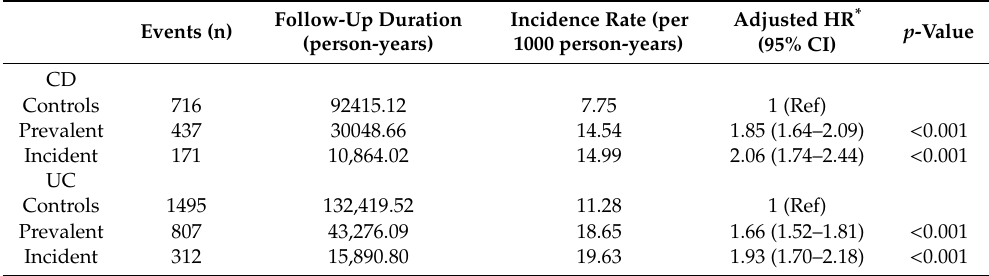
Table 3. Incidence and risk of depression in patients with inflammatory bowel disease compared to the general